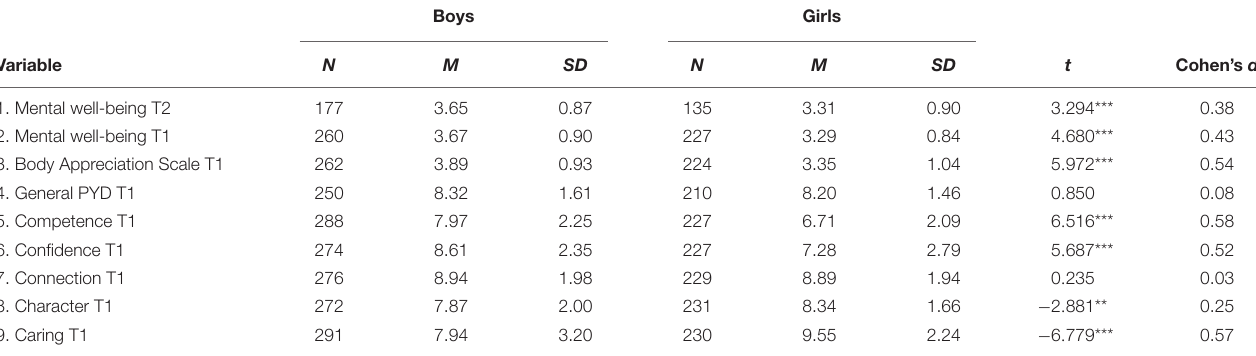
TABLE 2 | Independent samples t -test statistics for study variables by gender. Boys